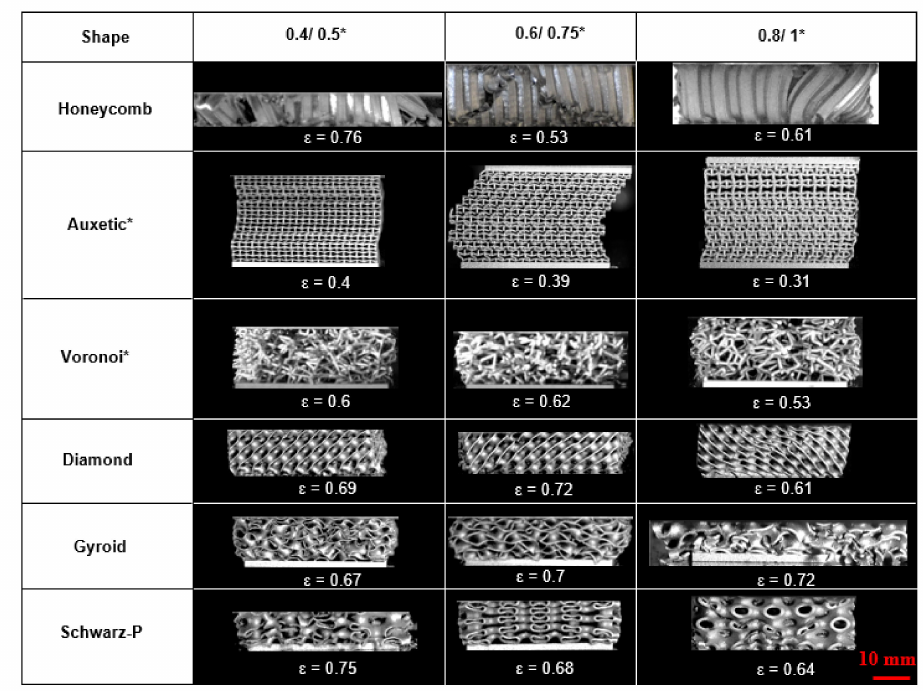
Figure 22. Deformation of cellular structures at the densification strain, mentioned below the picture of individual cellular shape. * Dimensions marked with * correspond to structures marked with